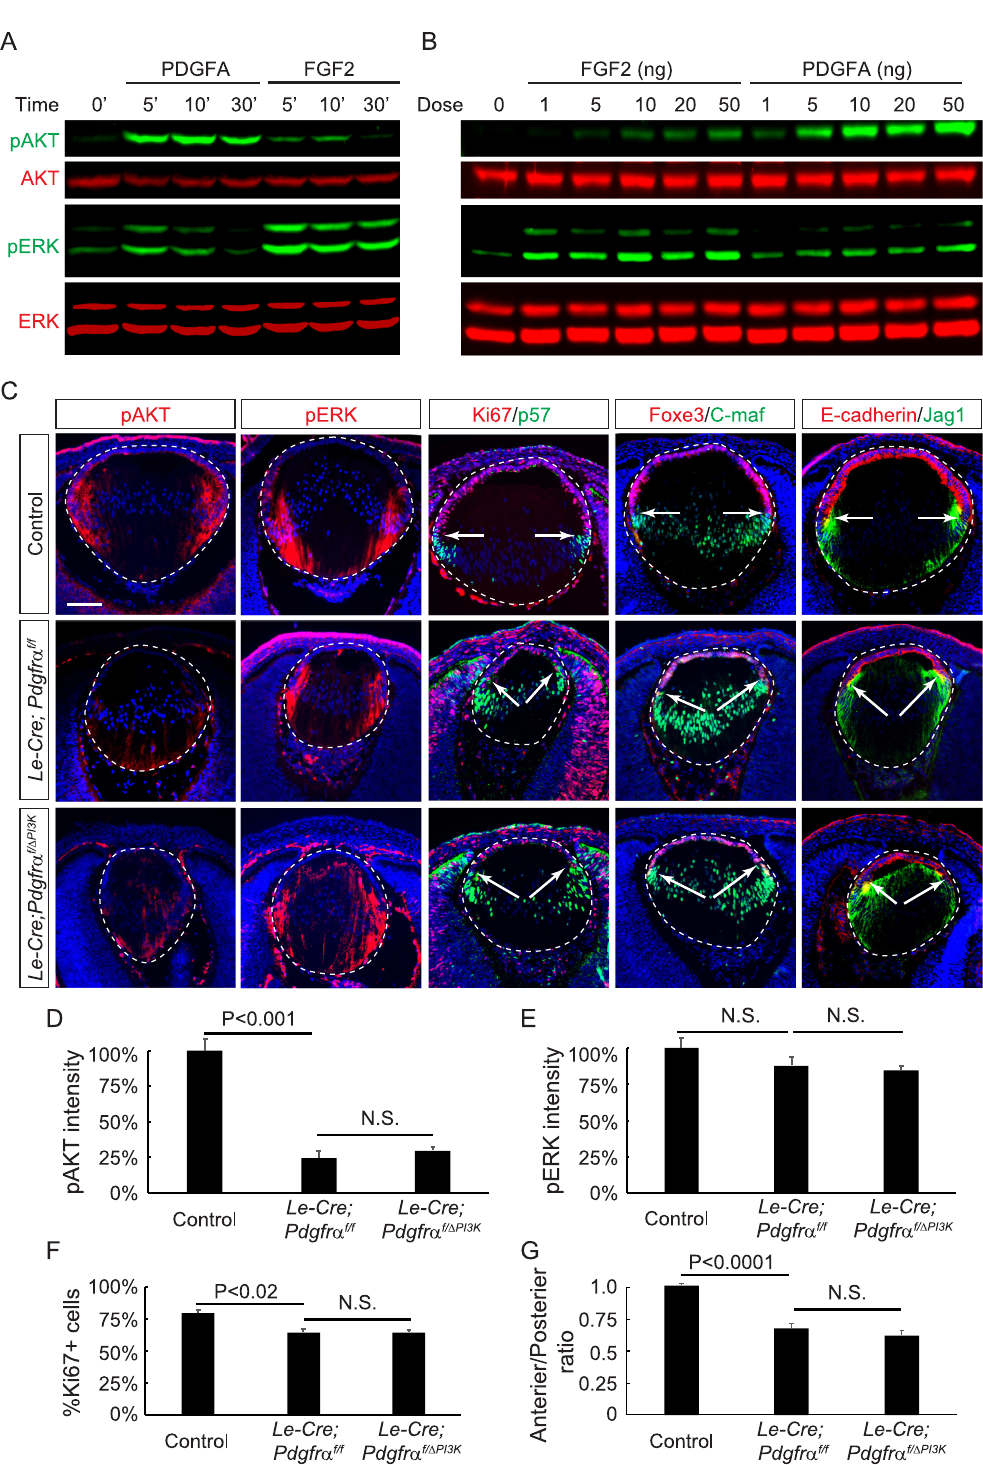
Fig 2. PI3K–AKT signaling is regulated by PDGFR α during lens development. (A–B) AKT phosphorylation was strongly stimulated by PDGFA but weakly by FGF2 in immortalized lens cells. In contrast, FGF2, but not PDGFA, induced strong ERK phosphorylation. ( C ) pAKT was down-regulated in mutant lenses lacking Pdgfr α ( Le-Cre;Pdgfr α f/f ) and in lenses expressing a mutant allele of Pdgfra that prevents interaction with PI3K ( Le-Cre; Pdgfr α f/ Δ PI3K ). However, ERK phosphorylation was unaffected in either Pdgfra mutant. Staining of the anterior progenitor markers Ki67, Foxe3, and